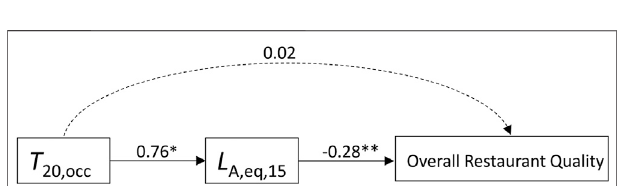
FIGURE 6 | Mediation analysis on acoustical parameters predicting overall restaurant quality. Note: The estimates represent standardized regression coef fi cients β , and the asterisks indicate the signi fi cance of the respective effects, * p < 0.05, ** p < 0.01, as obtained by the SEM routine of the Lavaan Package in R/RStudio. Structural equation model including acoustical and non-acoustical parameters.